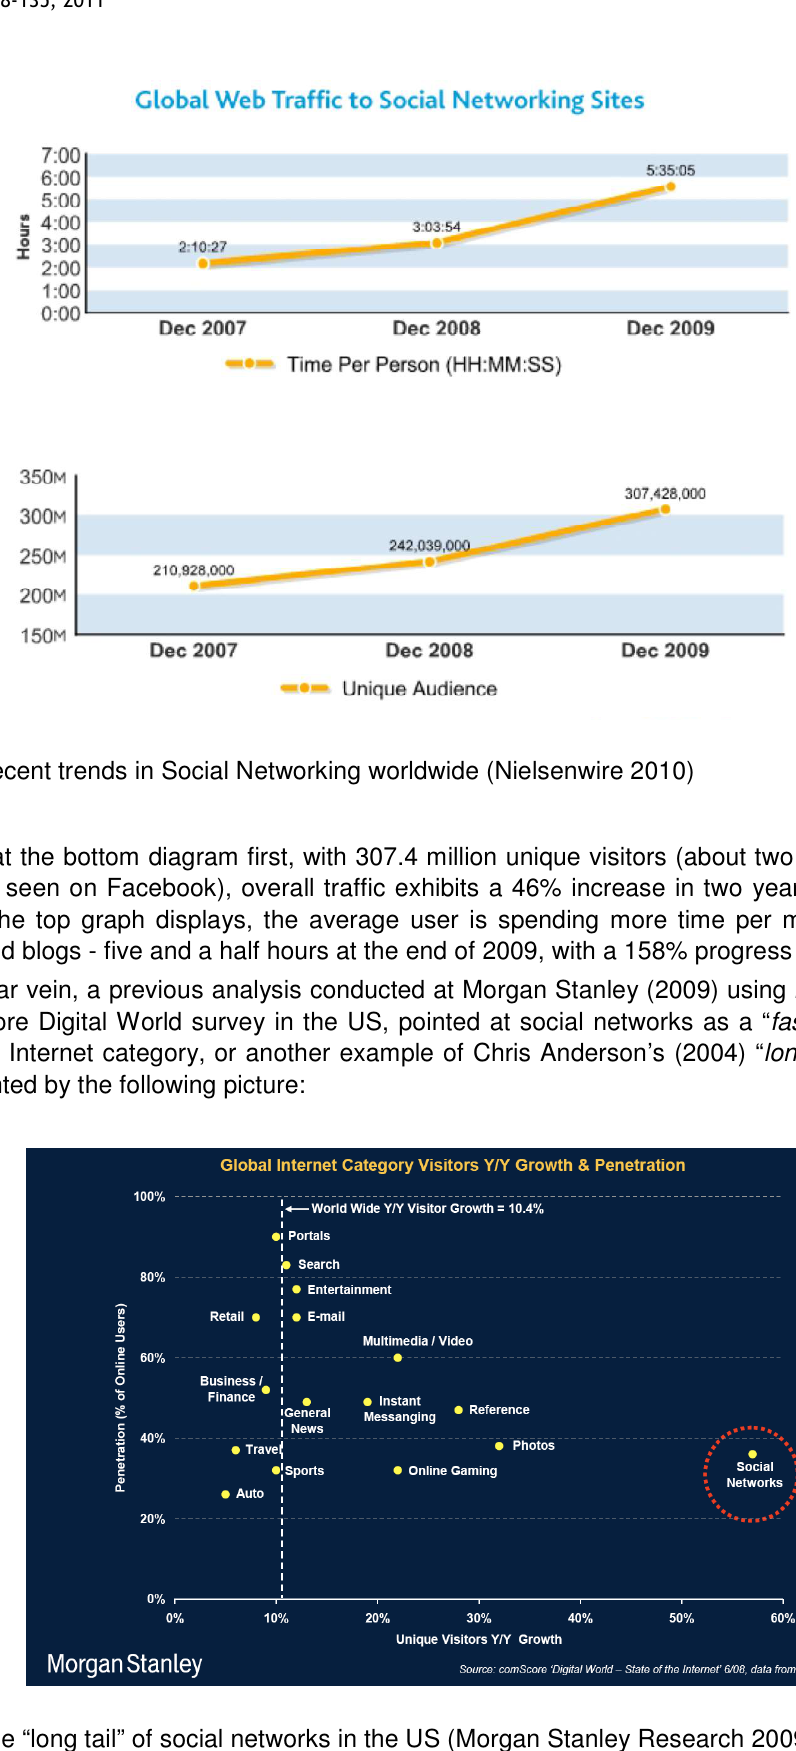
Figure 2: The “long tail” of social networks in the US (Morgan Stanley Research